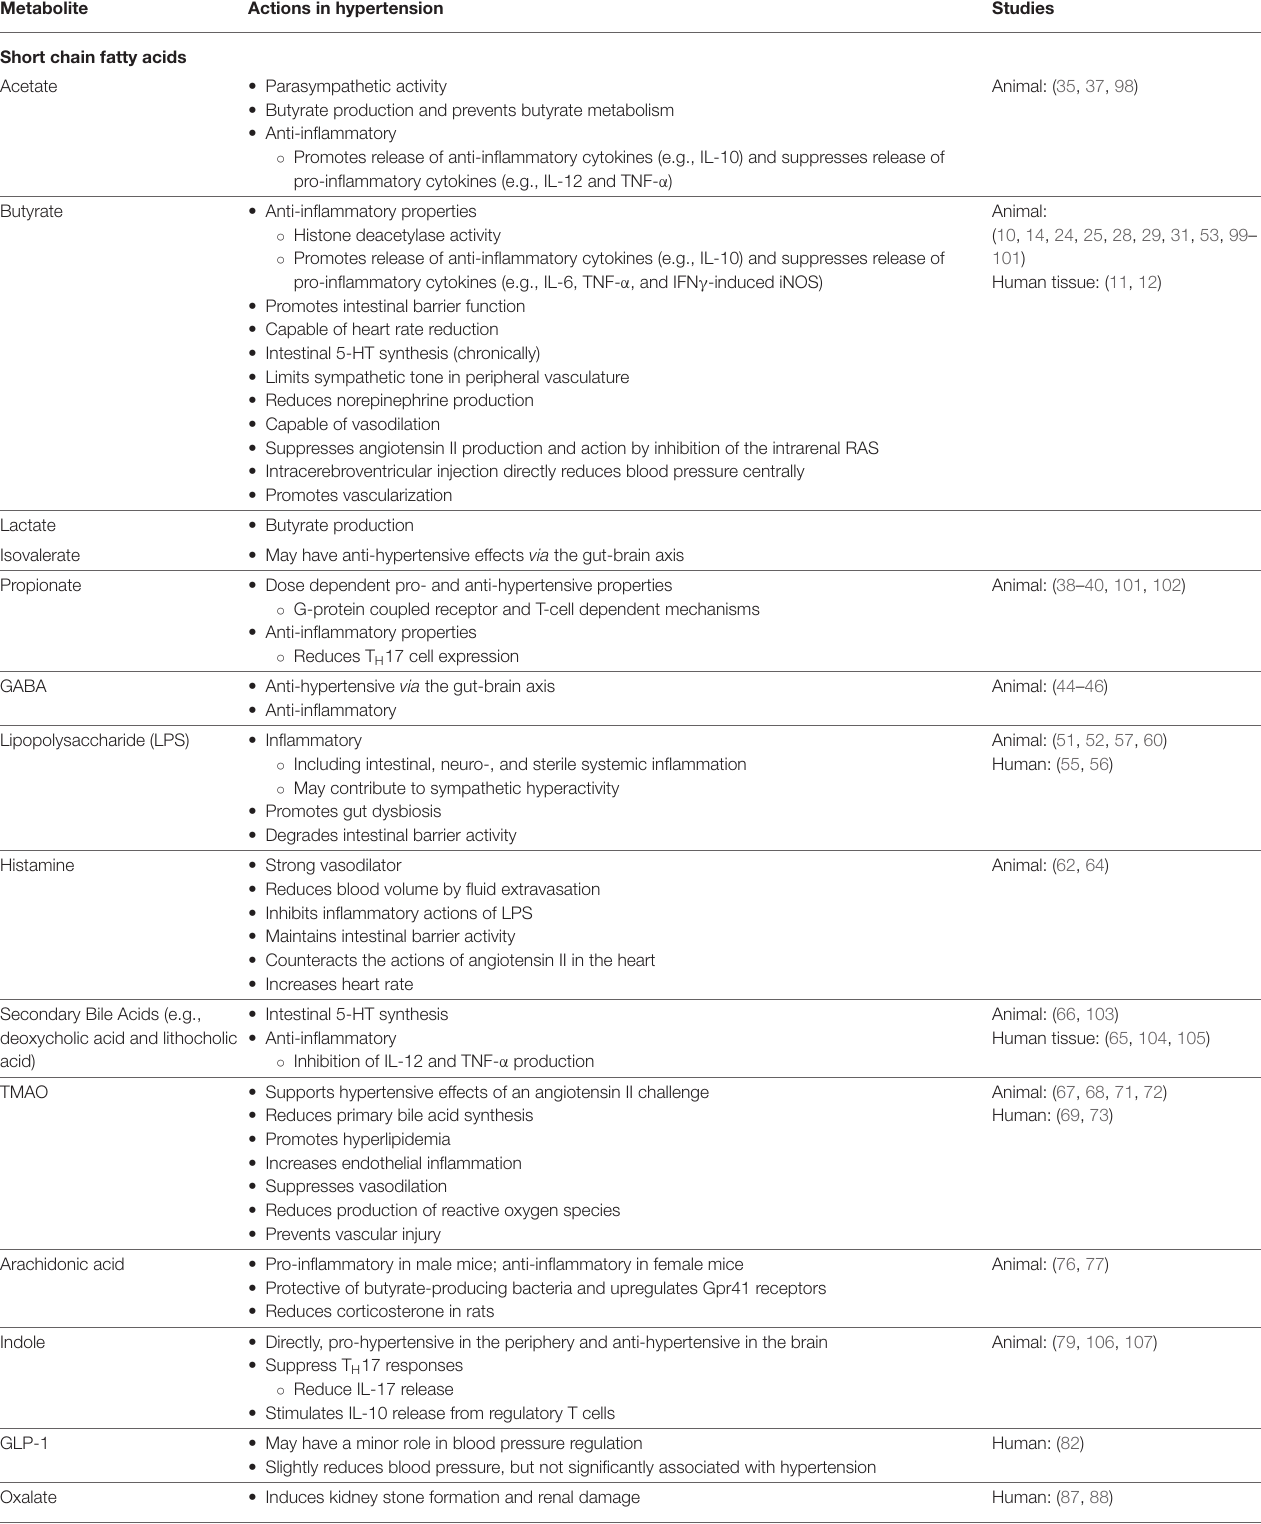
TABLE 1 | A summary of gut-derived metabolites and their general functions in hypertension. Metabolite Actions in